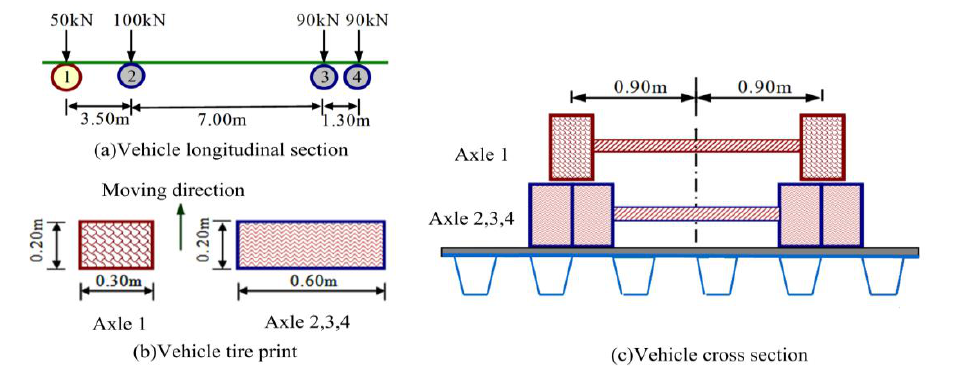
Figure 15. Fatigue load model.